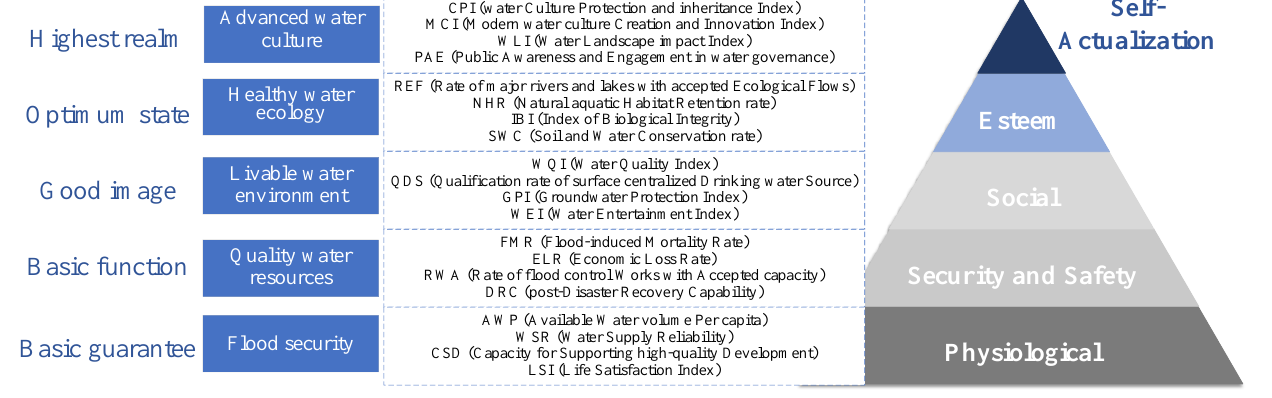
Figure 2. Framework of the RHI.